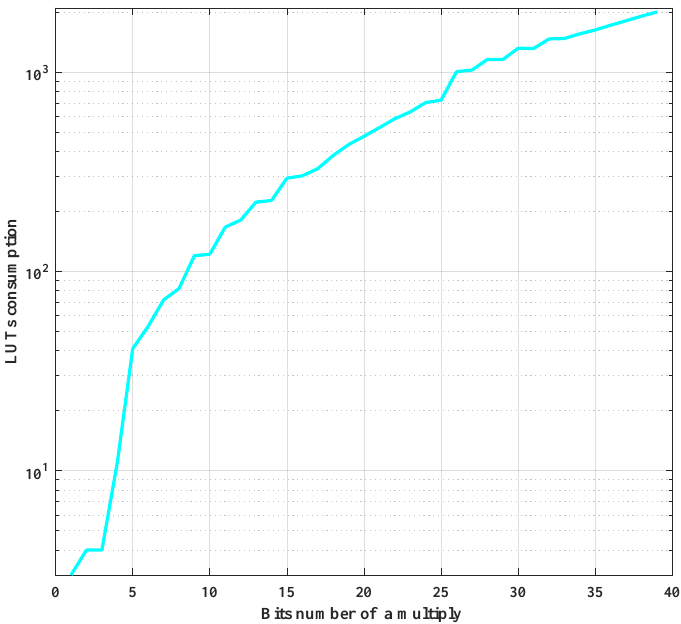
Figure 13. The lookup table (LUT) consumption of the multiply in different bits